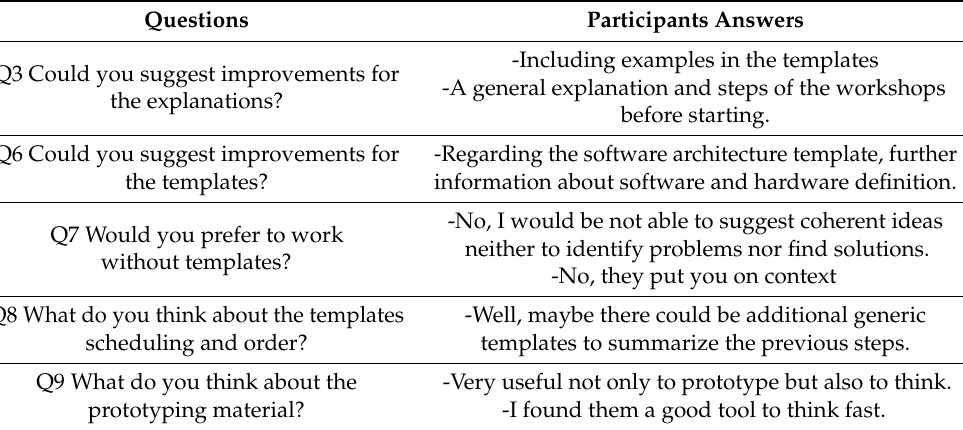
Figure 14. Participants’ answers on categorical scaled questions. Table 5. Participants answers to open questions.